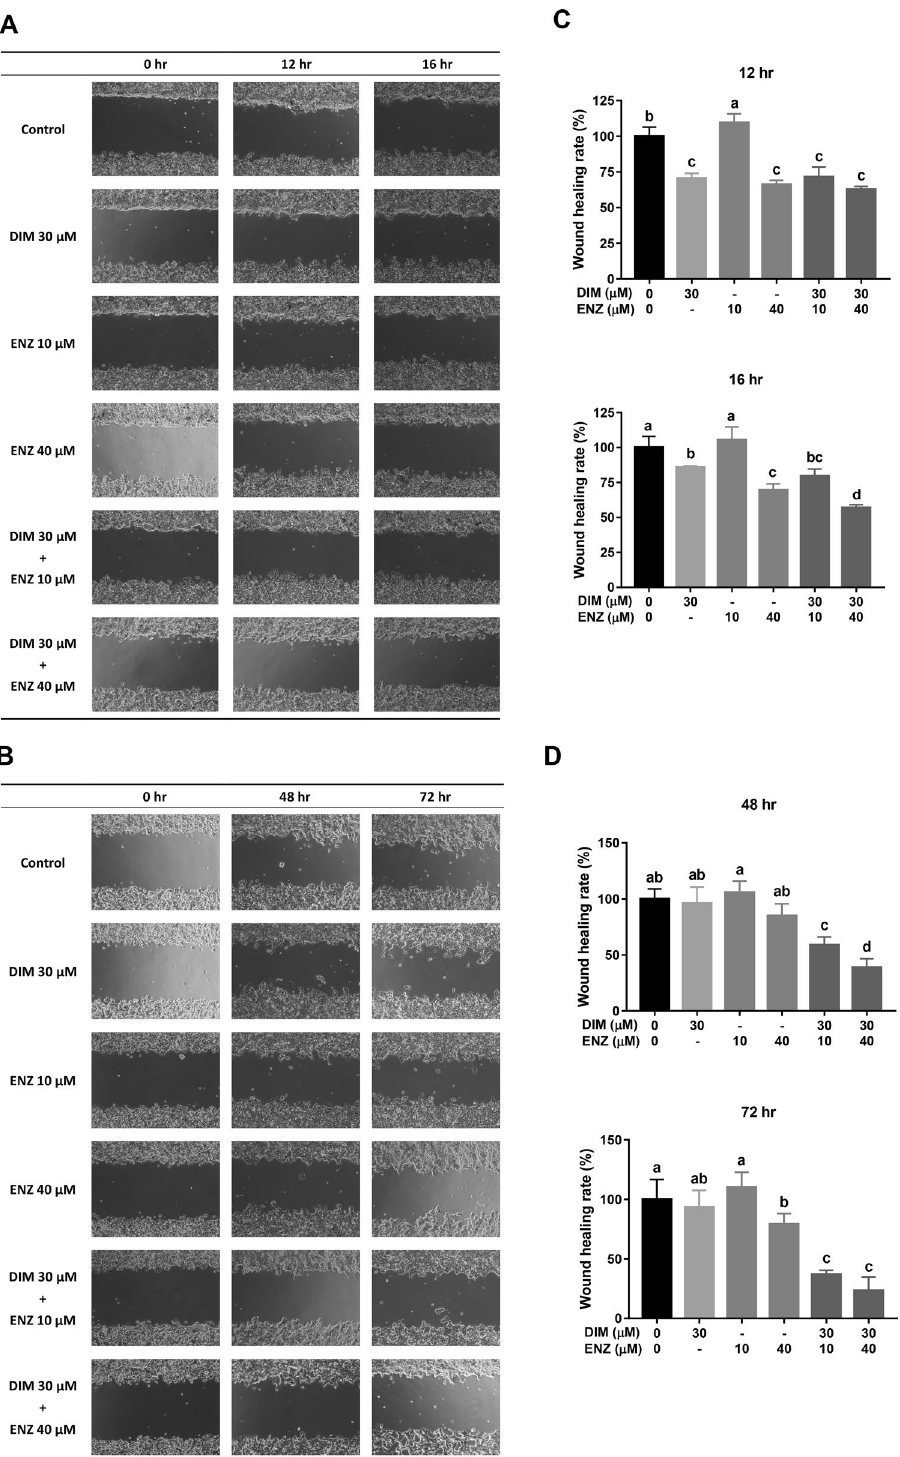
Figure 4. DIM and ENZ co-treatment augments the suppression of PCa cell migration (n = 4). Representative images at 12 and 16 h ( A ), 48 and 72 h ( B ); wound-healing rate ( C ). DIM 3,3 ′ -diindolylmethane; ENZ enzalutamide. Values are presented as means ± SD. a,b,c Bars without the same letters at the top indicate statistically-significant differences between treatments when compared with each other (one-way ANOVA, Duncan’s new multiple range test, p <